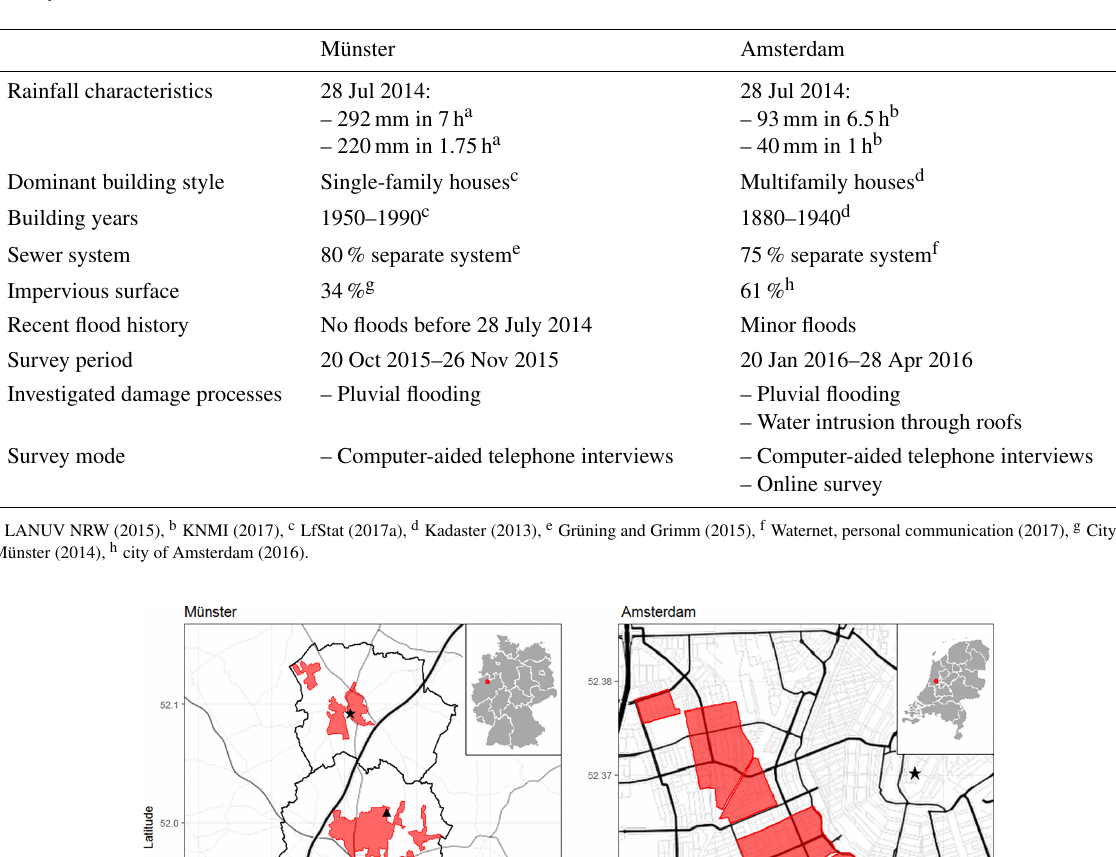
tre is around 90 % and on a city-wide level 34 %.